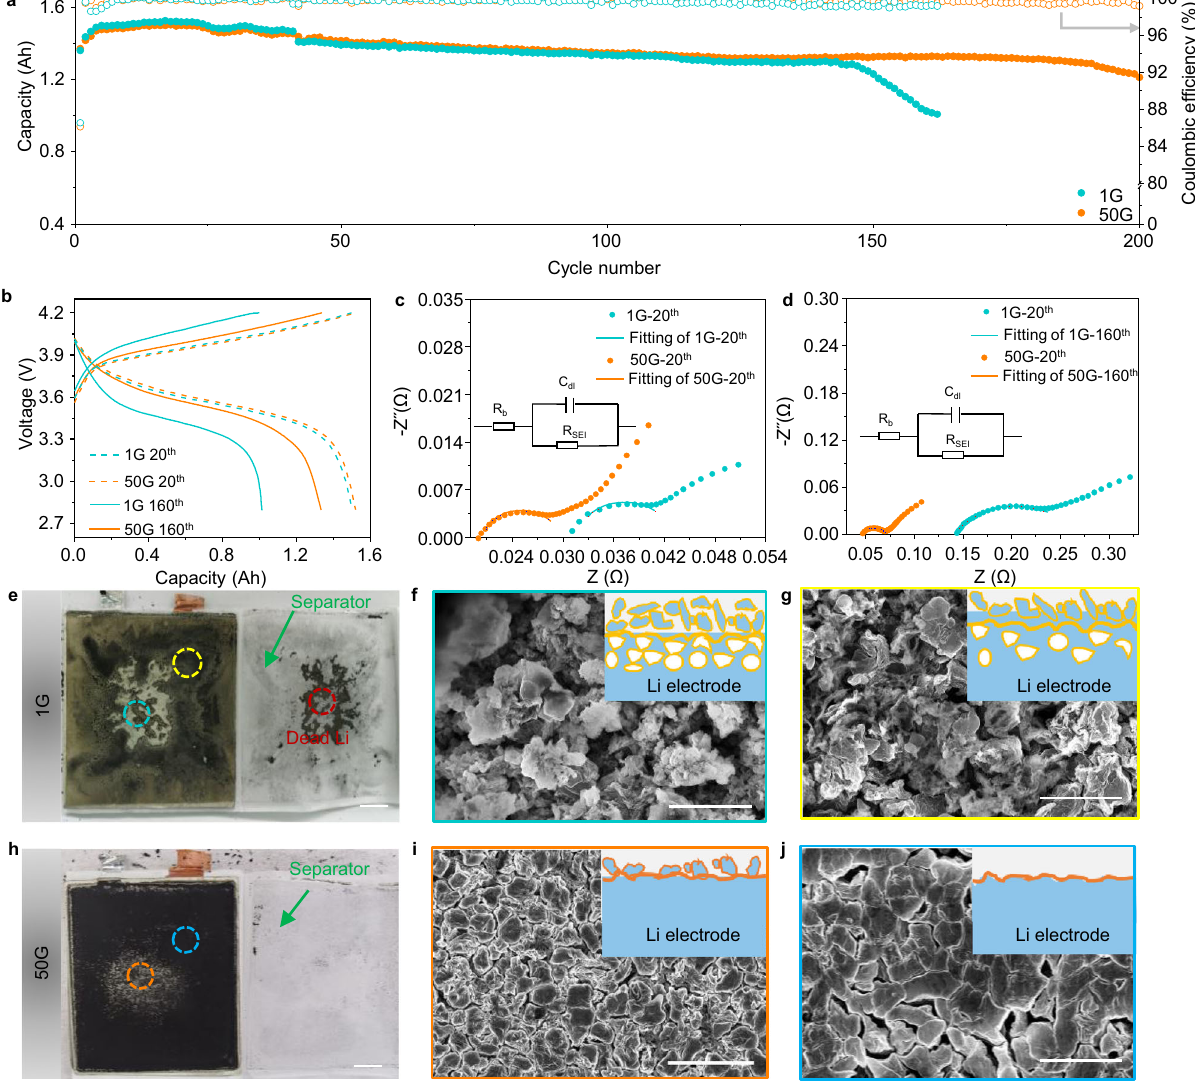
Fig. 7 Electrochemical performances of 2.5 Ah high-energy Li | |NCM811 pouch cell under different gravity conditions. a Cycling performances of pouch cells at 2 C (400 mA g − 1 ) rate. b The representative charging/discharging voltage pro fi les of the pouch cell at 1G and 50G with different cycles. Comparison of impedance spectra of pouch cells after c 20 and d 160 cycles at 1G and 50G (the inserted equivalent circuit represents the fi tted impedance result). e , h Digital photos and f − j SEM images of the Li electrode after 160 cycles in pouch cell at 1G and 50G, respectively (the inserted schematic illustrations show the corresponding electrodeposition morphology). Scale bars are 1 cm in ( e , h ) and 10 µ m in ( f , g , i , and j